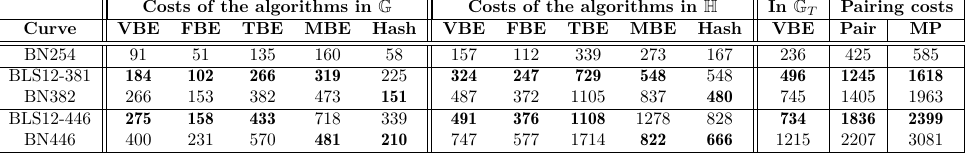
Table 1: The computational costs of various algorithms on the elliptic curves used in our comparison, expressed in the number of 10 3 clock cycles. For each pair of curves with the same security level, the lowest costs are typeset in bold . These benchmarks were run on an AMD Ryzen 7 PRO 4750 processor, with power management disabled and throttle to max. frequency (one single core) at 4.1 GHz. Note that TBE and MBE denote a two-base exponentation (run with _mul_sim ) and multi-base exponentiation with two bases (run with _mul_sim_lot ), respectively, and MP a multi-pairing with two pairings. Costs of the algorithms in G Costs of the algorithms in H In G T Pairing costs Curve VBE FBE TBE MBE Hash VBE FBE TBE MBE Hash VBE Pair